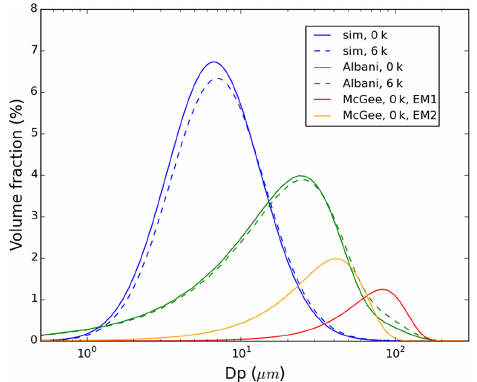
Figure 6. Simulated aerosol size distribution of deposited fluxes at the position of marine core GC68 (blue), dust size distribution in the sediment core of Albani et al. (2015) (green) for 0 k (solid) and 6 k (dotted) and best-fit Weibull functions that represent the contribu- tion of the endmember corresponding to eolian inputs (endmember 1 (EM1, red) and 2 (EM2, orange) in McGee (2013)) for 0 k . Curves are normalized to an area of